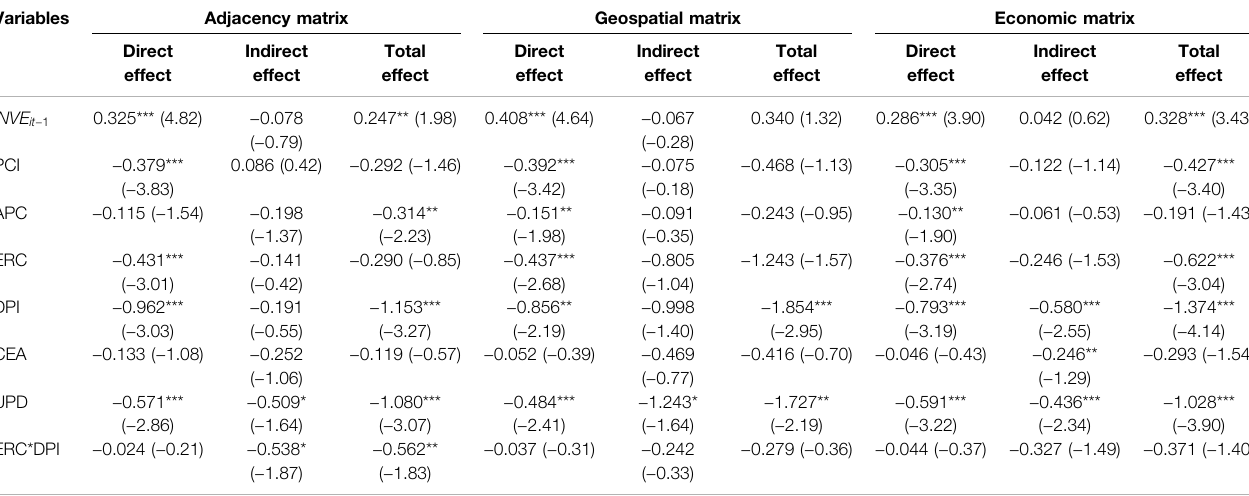
TABLE 7 | Decomposition of the random effects SDM (INVE3).